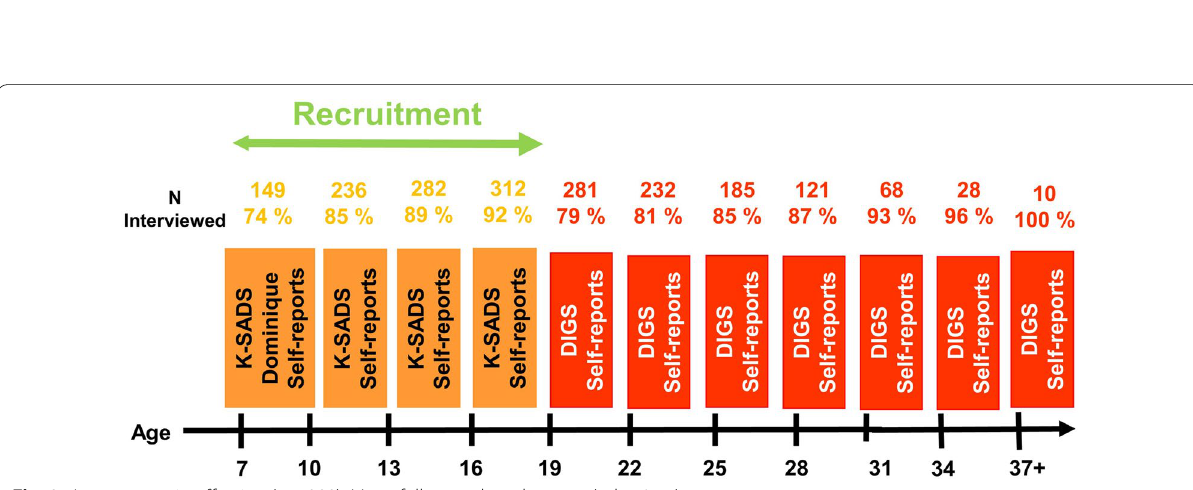
388). Mean follow‑up length: 14 yrs (s.d. 4.6 =